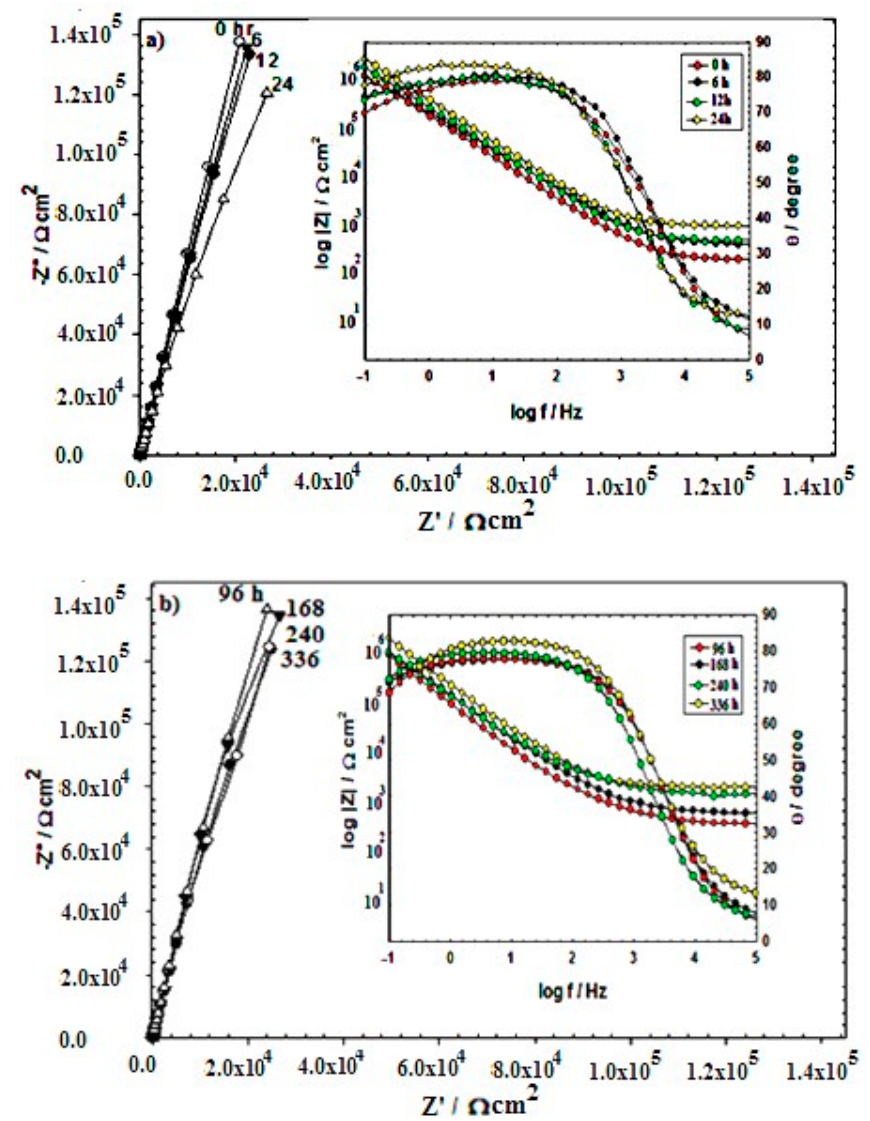
Figure 6. Nyquist plots and Bode plot inset of Ti alloy/CSNPs/PVP/CoONPs coating on the Ti alloy surface after immersion for ( a ) 0-24 h and ( b ) 96-336 h in artificial saliva at 37 °C.